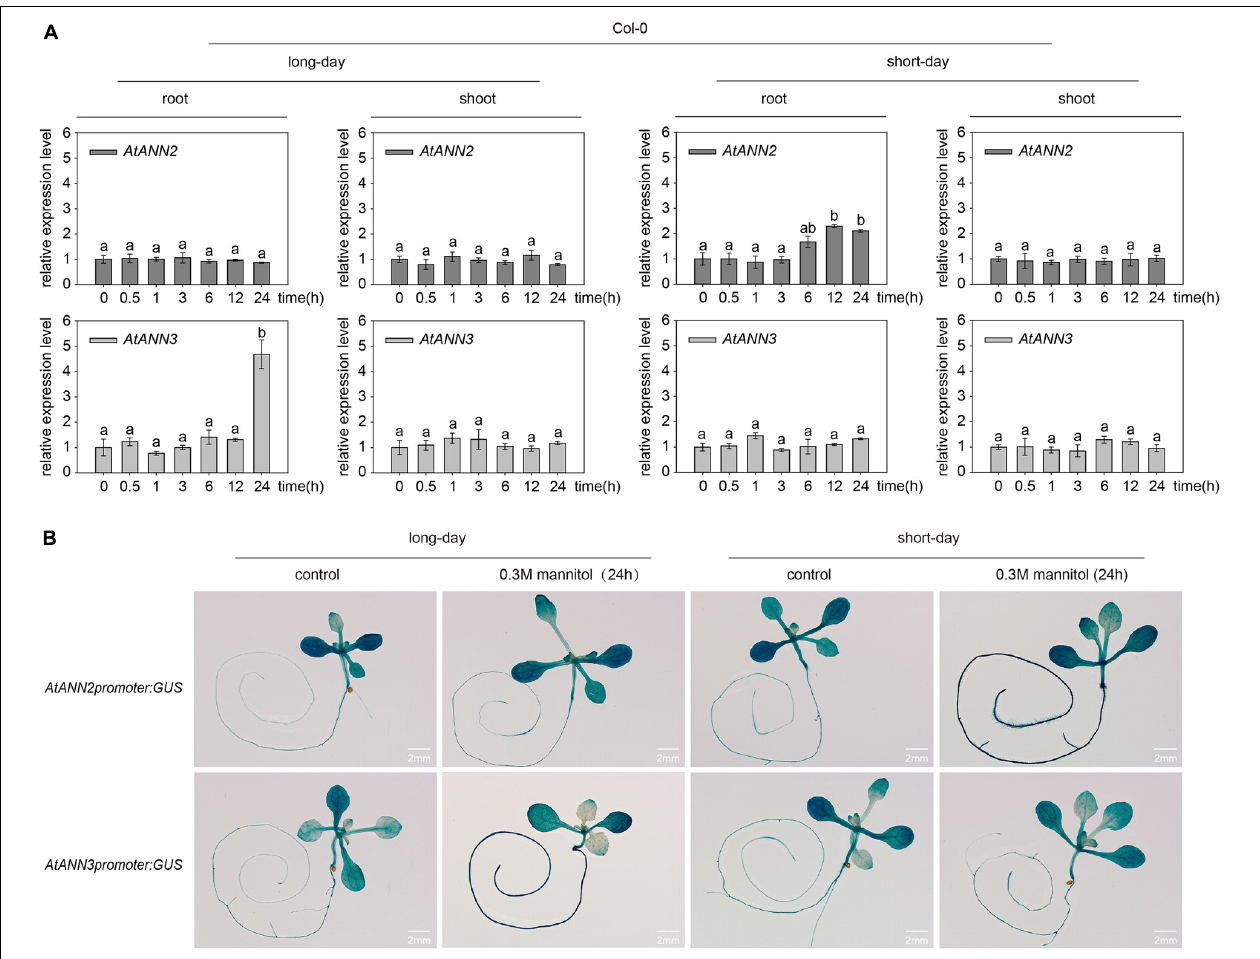
FIGURE 3 | Expression patterns of AtANN2 and AtANN3 in response to mannitol treatment under different photoperiods. (A) Relative expression levels of AtANN2 and AtANN3 in 300 mM mannitol-treated plants (Col-0) for 0, 0.5, 1, 3, 6, 12, and 24 h using qRT-PCR. Different letters indicate significant differences with each treatment at p <0.05 level. (B) Induction of GUS expression in Col-0 roots in response to 300 mM mannitol treatment for 24 h under different photoperiods. Scale bar = 2 mm.